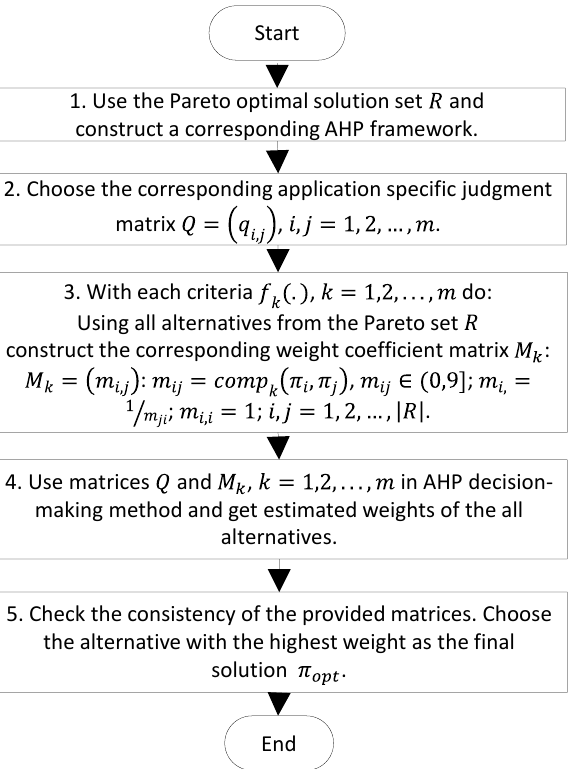
Figure 6. A flowchart of AHP for choosing the best path.